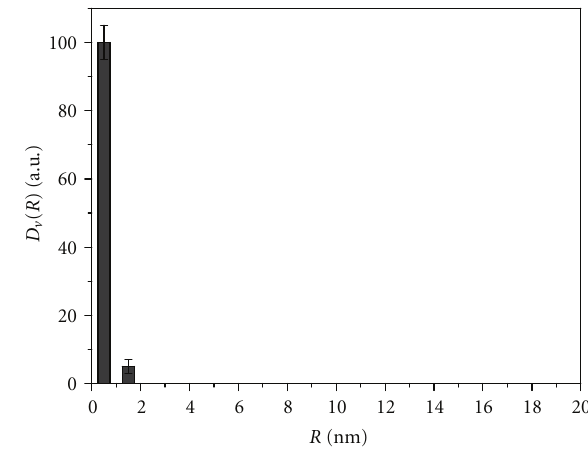
Figure 4: SAXS histogram of the particle size distribution in amorphous sample obtained by hydrolysis of TiCl 4 in the presence of ammonia.